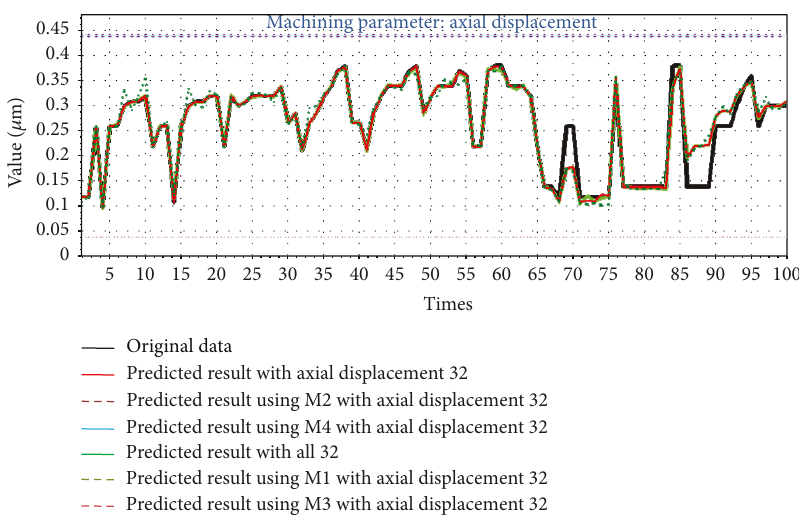
Figure 22: Predicted results of axial displacement of grinding wheel. Table 2: Average accuracies of predicted results with single